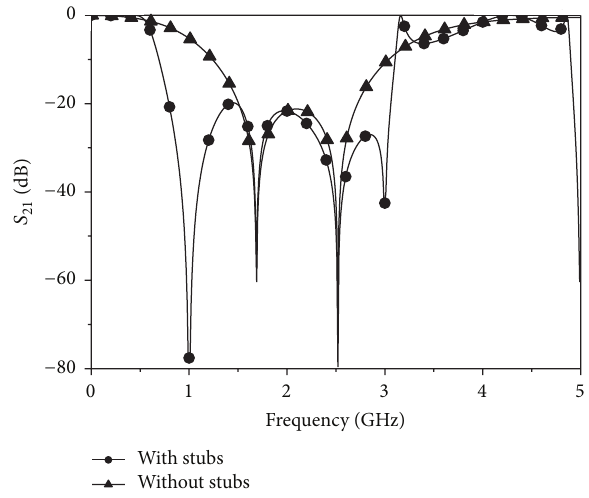
Figure 5: The simulated frequency response with and without the